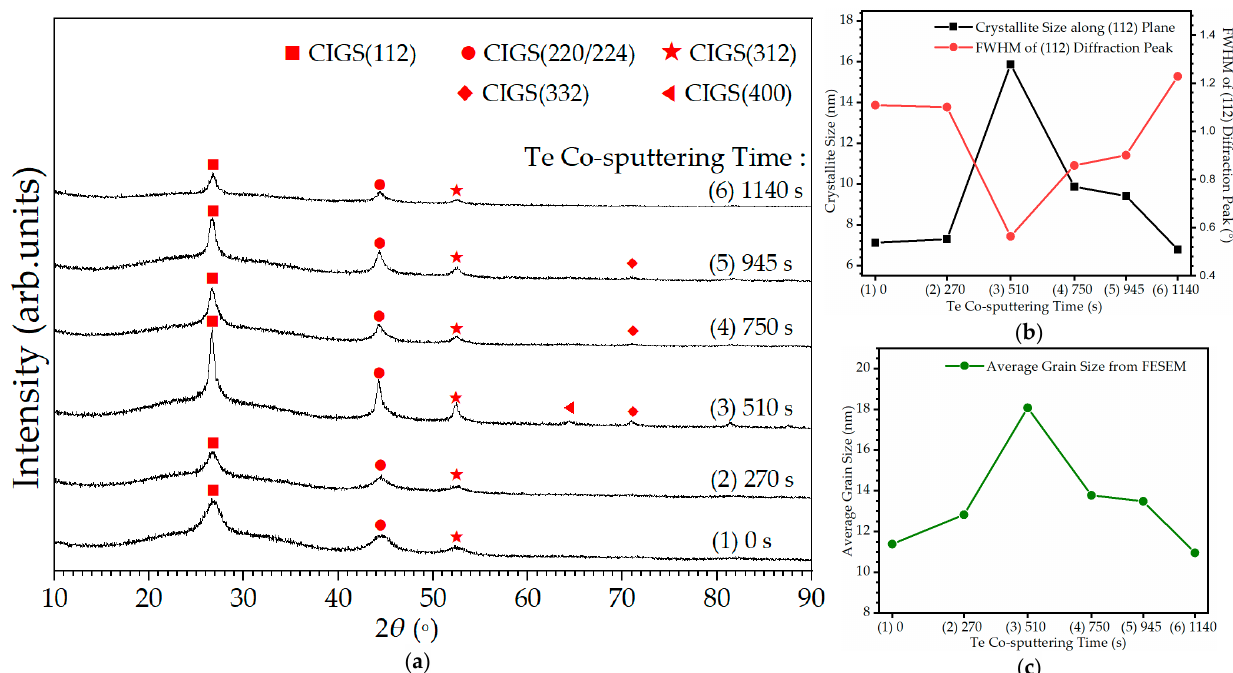
Figure 3. ( a ) X-ray diffraction (XRD) patterns, ( b ) crystallite size along the (112) plane and full widths at half maximum (FWHM), and ( c ) average grain sizes of the CIGS:Te thin films with different Te co-sputtering times of (1) 0, (2) 270, (3) 510, (4) 750, (5) 945, and (6) 1140 s.